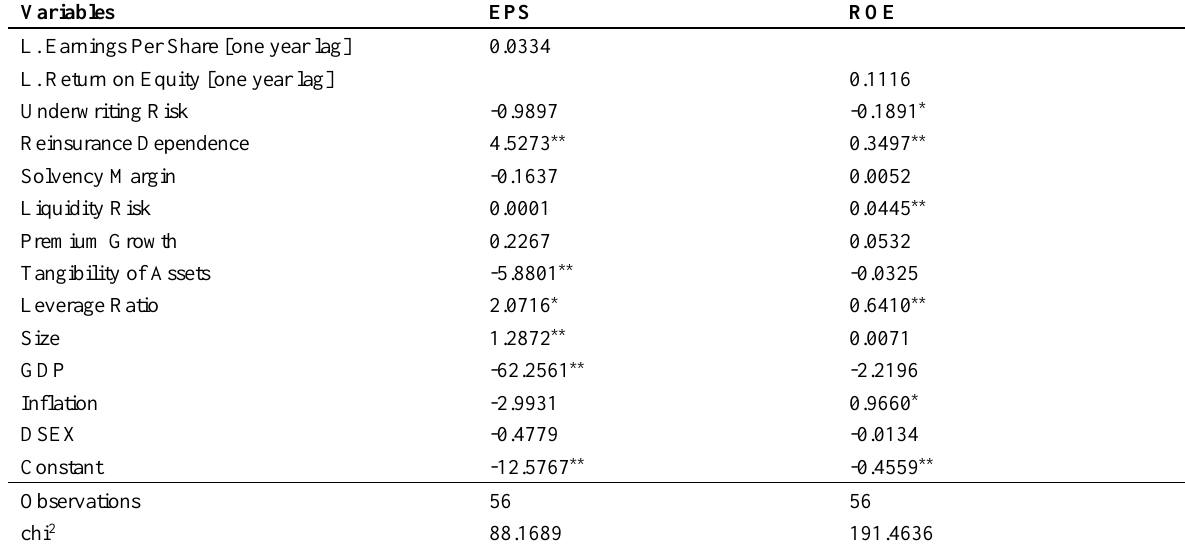
Table 14: Summary of the output of GMM Approach of two Models based on eqauation 07 and